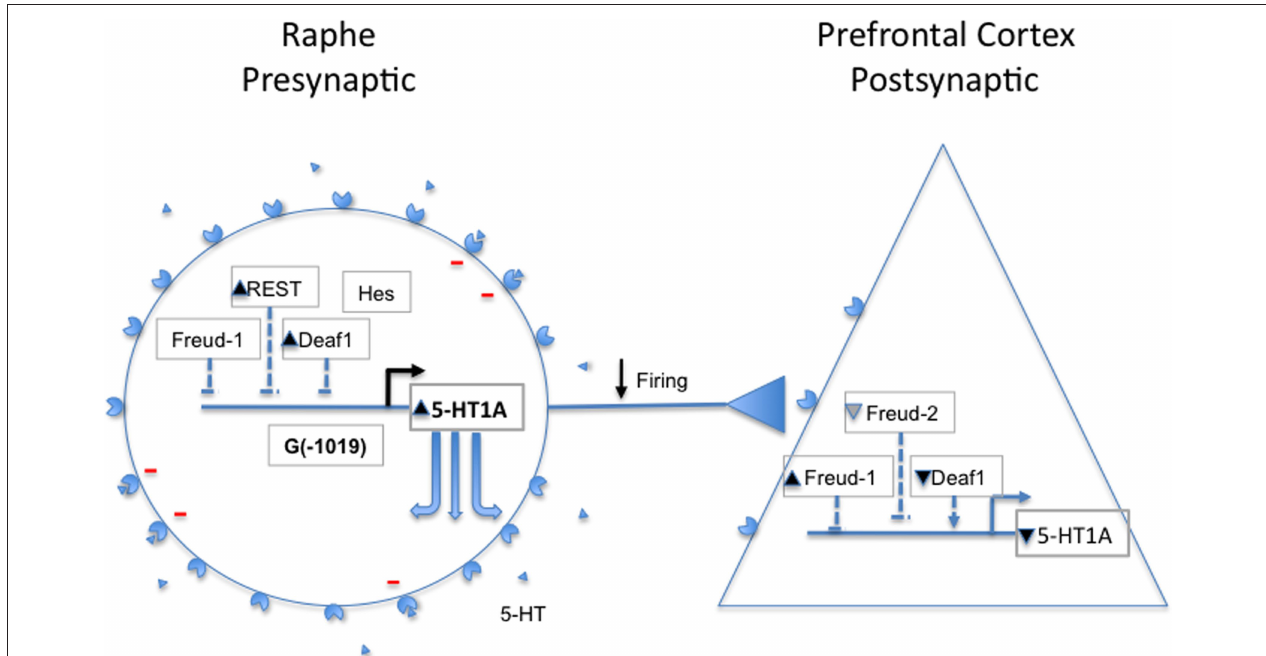
presynaptically, leading to inhibition of 5-HT neurons (red-) and reduced firing. Paradoxically, the presynaptic levels of repressors REST and Deaf1 are increased, and there is also a trend for increase in Freud-1, perhaps to compensate for 5-HT1A overexpression due to the G( − 1019) allele, for example. Post-synaptically, 5-HT1A receptors appear reduced, and levels of Deaf1 are also lower, although Freud-1 and Freud-2 (trend) increase. See text for details and